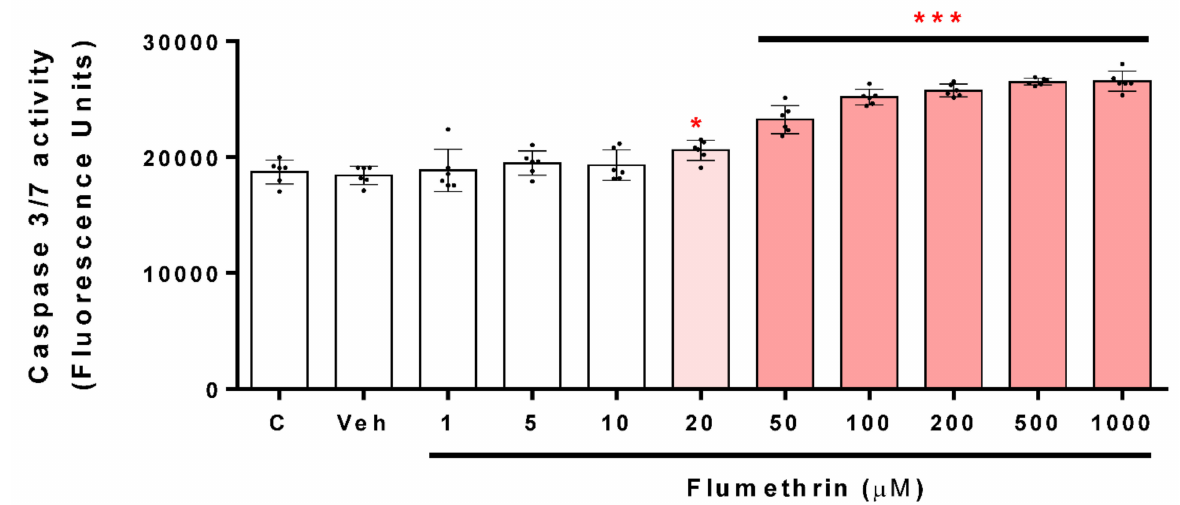
Figure 5. The caspase 3/7 activity induced by flumethrin (1–1000 µ M) in SH-SY5Y cells after a 24 h incubation period. DMEM-treated cells with DMEM with 1% FBS were the positive control (c), and cells with 0.1% DMSO were the negative control (Veh). Results are presented as the mean ± SD of six replicates. * p < 0.05, *** p < 0.001 compared to Veh.